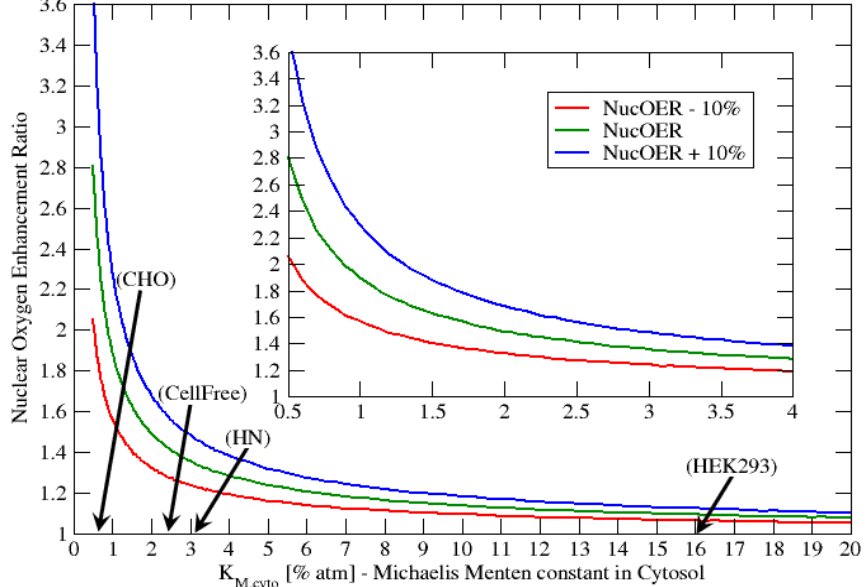
Figure 9. Concentration ratio vs. K M , cyto for fixed extracellular oxygen concentration C 0 = 4% atm and four different multiplying factors, taking as a reference ν ER = 1.5 · ν cyto